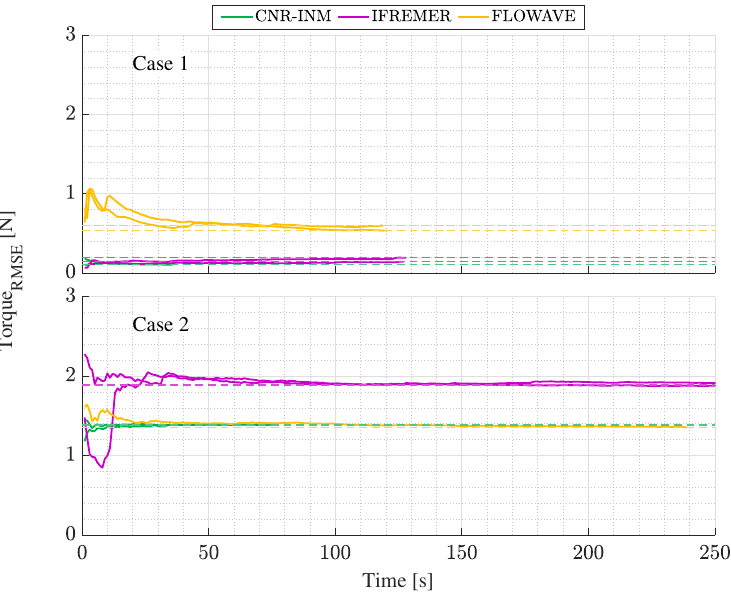
Figure 18. Stabilisation of the torque RMSE at TSR = 4 for case 1 ( top ) and 2 ( bottom ) at all facilities. Dashed lines are the RMSE value of the whole time series; same-colour curves are repeat tests when